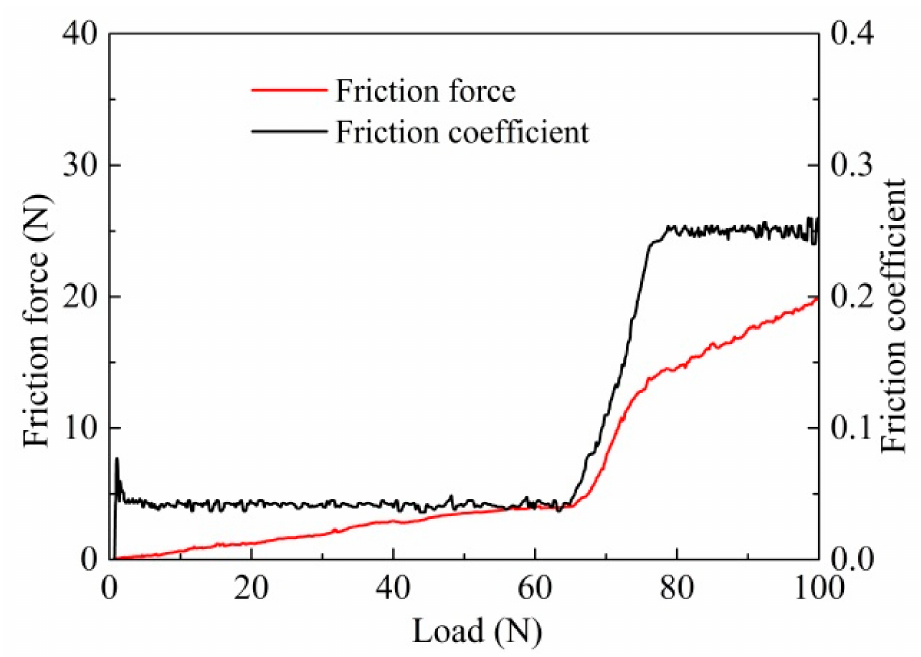
Figure 4. Adhesive strength curve in a scratch test of T180 coated